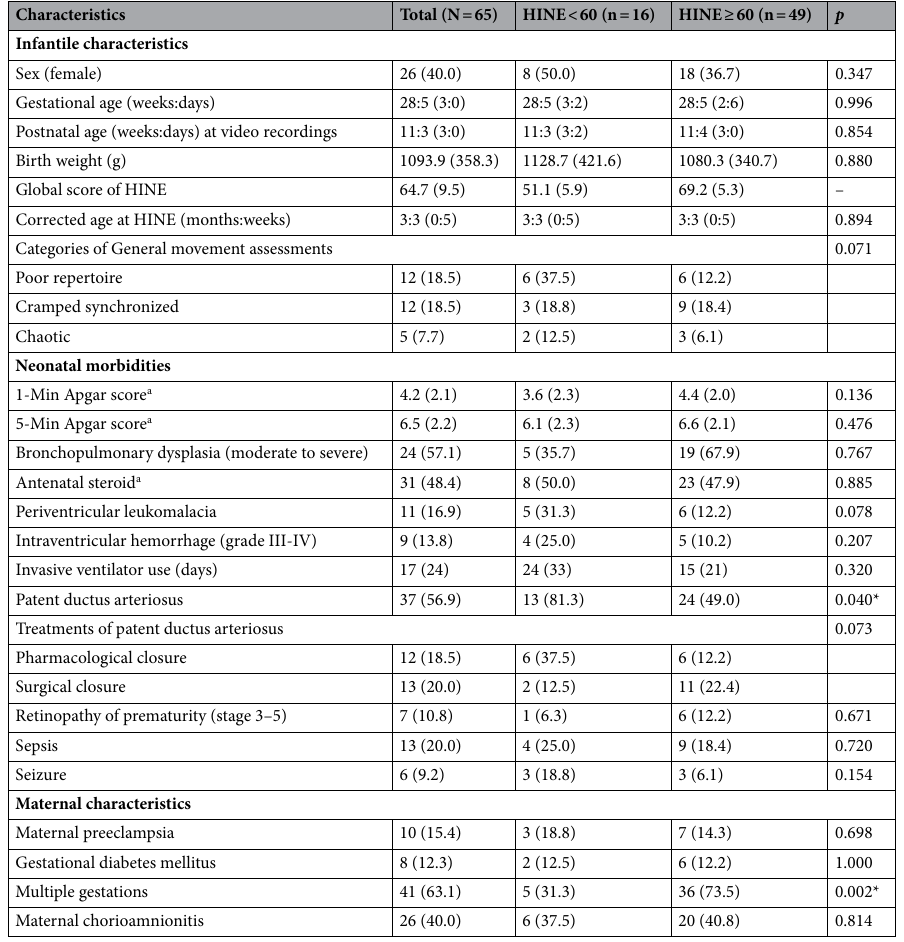
Table 1. Clinical characteristics. Values are presented as mean (standard deviation) or number of participants. HINE Hammersmith infant neurological examination. * p < 0.05. a One patient was not included in the analysis due to missing